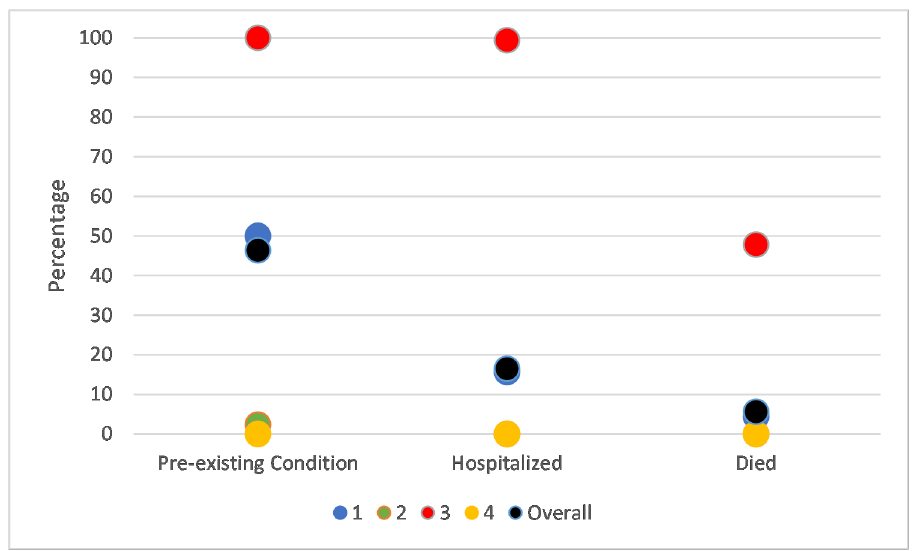
Figure 3. Percentage of individuals who fall into health categories for overall sample of 10,000 and for each of the four clusters. Same information as in last three columns of Table 4.